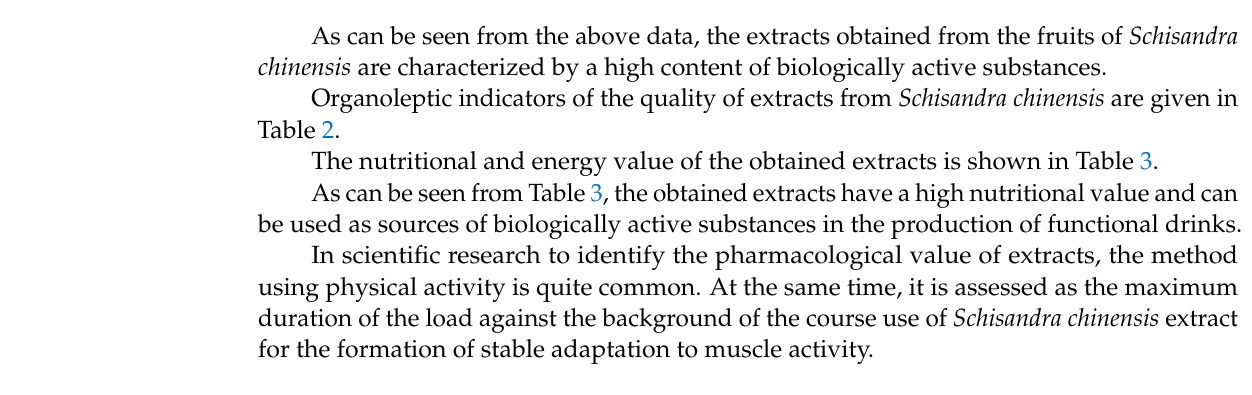
Table 1. The content of biologically active substances in extracts from Schisandra Chinensis (Turcz. Baill). BAS Content,% Raw Materials Tannins Phenolic Compounds Anthocyanins Organic Acids Schisandra Chinensis (Turcz.